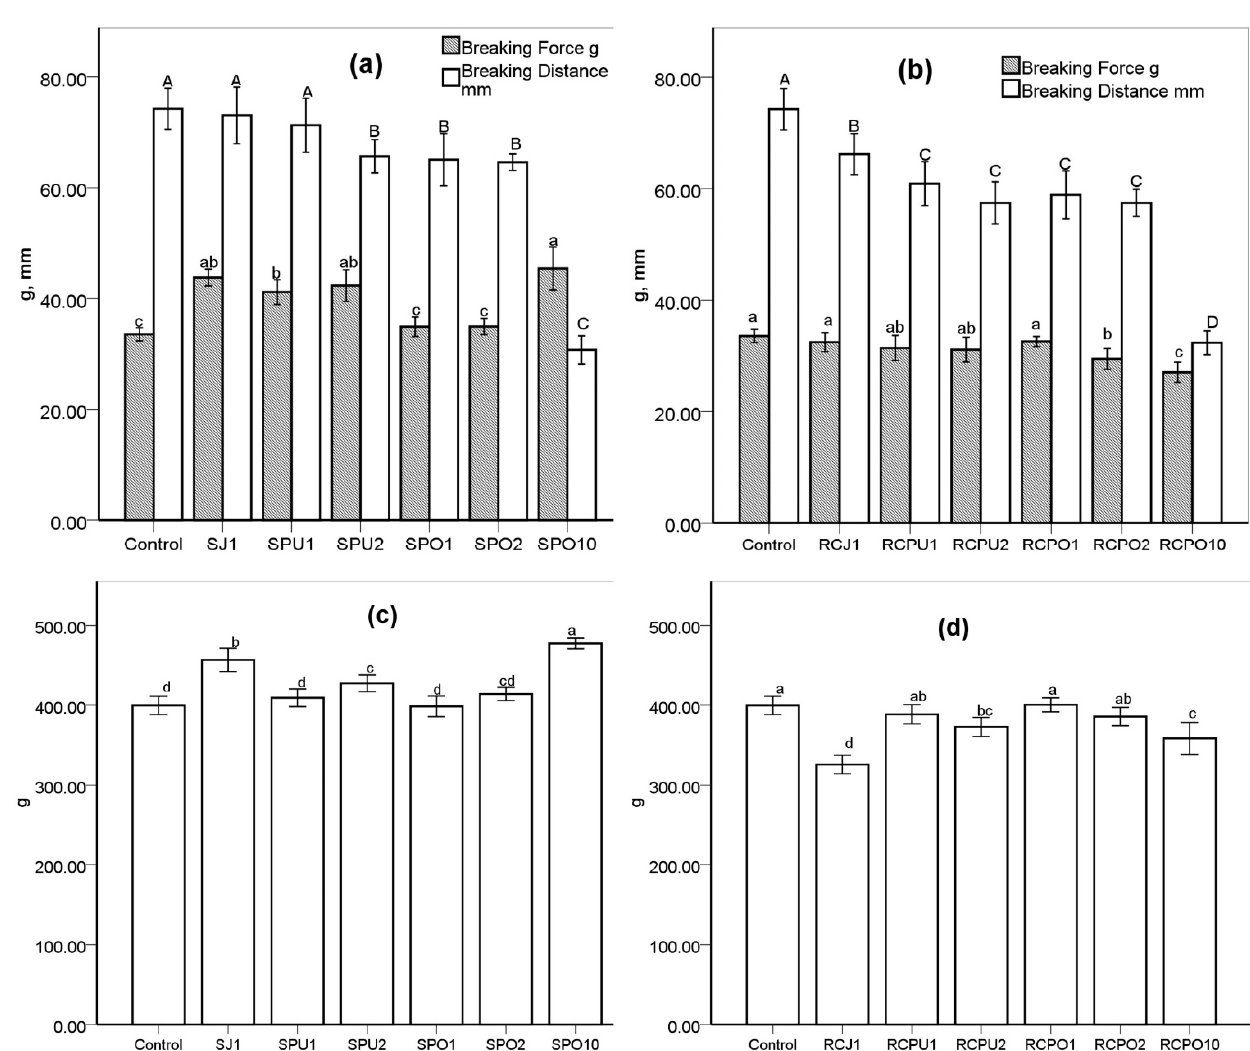
Figure 1. ( a ) Elasticity of spinach pasta, ( b ) Elasticity of red cabbage pasta, ( c ) Firmness of spinach pasta, ( d ) Firmness of red cabbage pasta. SJ, SPU, SPO represent spinach juice, spinach puree, spinach pomace, respectively; RCJ, RCPU, RCPO represent red cabbage juice, red cabbage puree, red cabbage pomace, respectively; 1, 2, and 10 is the substitution level (g/100 g) based on the dry weight. C: control sample. Error bars present the standard deviation of replicates. The same letter mean values are not significantly different from each other ( p > 0.05)